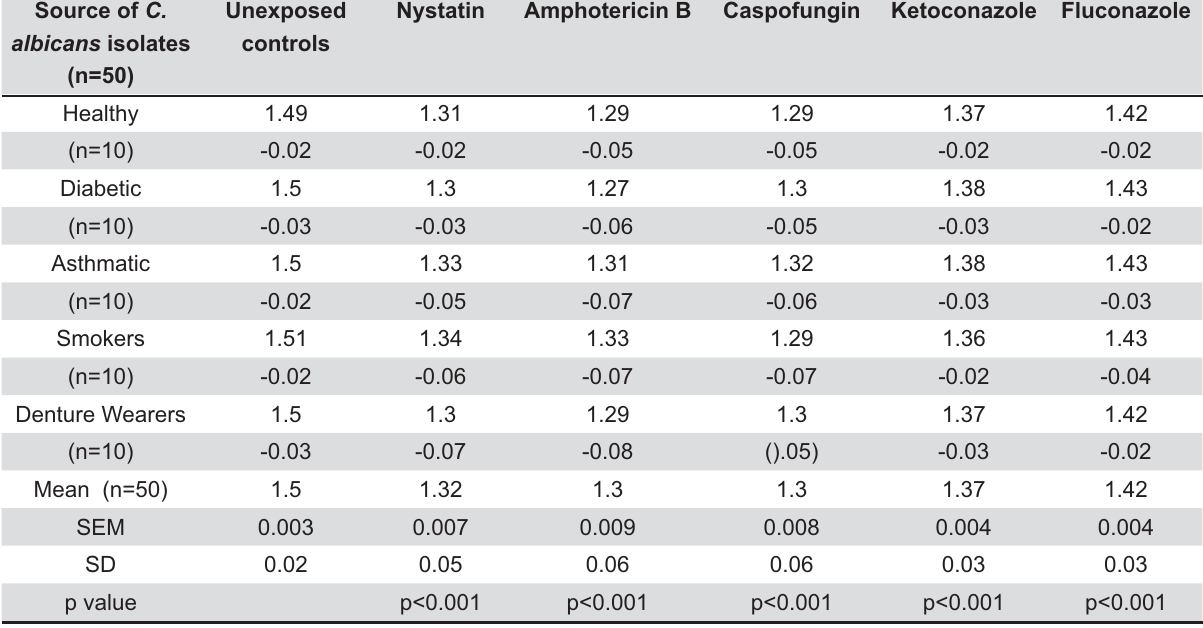
Table 2- Mean (SD) hemolysin activity (hemolytic index) of 50 oral C. albicans isolates following 1 hour exposure and (cid:18)(cid:16)(cid:29)(cid:18)(cid:3)(cid:30)(cid:16)(cid:3)(cid:14)(cid:15)(cid:9)(cid:2)(cid:3)(cid:4)(cid:5)(cid:6)(cid:7)(cid:8)(cid:9)(cid:5)(cid:10)(cid:9)(cid:11)(cid:6)(cid:3)(cid:9)(cid:12)(cid:13)(cid:10)(cid:10)(cid:3)(cid:2)(cid:3)(cid:14)(cid:15)(cid:9)(cid:7)(cid:14)(cid:15)(cid:13)(cid:10)(cid:16)(cid:14)(cid:17)(cid:7)(cid:8)(cid:9)(cid:12)(cid:2)(cid:16)(cid:17)(cid:18)(cid:19)(cid:9)(cid:20)(cid:7)(cid:21)(cid:22)(cid:9)(cid:6)(cid:7)(cid:8)(cid:16)(cid:3)(cid:9)(cid:13)(cid:14)(cid:12)(cid:13)(cid:21)(cid:7)(cid:15)(cid:3)(cid:18)(cid:9)(cid:15)(cid:22)(cid:3)(cid:9)(cid:4)(cid:3)(cid:7)(cid:14)(cid:9)(cid:23)(cid:24)(cid:25)(cid:26)(cid:9)(cid:22)(cid:3)(cid:4)(cid:5)(cid:8)(cid:31)(cid:18)(cid:13)(cid:14)(cid:9)(cid:7)(cid:21)(cid:15)(cid:13)(cid:6)(cid:13)(cid:15)(cid:31)(cid:9)(cid:5)(cid:10)(cid:9)(cid:27)(cid:28)(cid:9)(cid:5)(cid:2)(cid:7)(cid:8)(cid:9) C. albicans obtained either from healthy individuals, diabetic patients, asthmatic patients, smokers or denture wearers. SD: Standard deviation. SEM: Standard error of mean